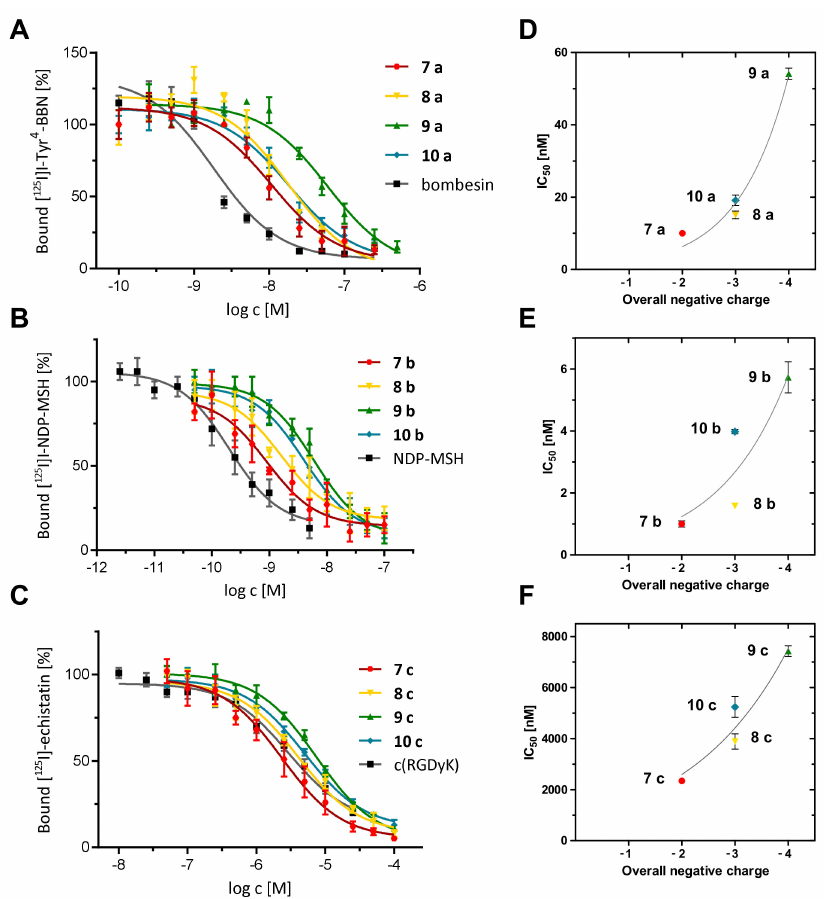
Figure 6. Results of the competitive displacement assays of the peptide-MIU-bioconjugates on different tumor cell lines. Depiction of the determined binding curves of: ( A ) 7 a - 10 a and the reference bombesin, tested on stably GRPR-transfected HEK-293 cells, using [ 125 I]I-Tyr 4 -bombesin as the competitor, ( B ) 7 b - 10 b and the reference NDP-MSH, tested on MC1R-positive B16F10 cells, using [ 125 I]I-NDP-MSH as the competitor, ( C ) 7 c - 10 c and the reference c(RGDyK), tested on α v β 3 - expressing U87MG cells, using [ 125 I]I-echistatin as the competitor. Correlation between the found IC 50 values and number of negative charges of: ( D ) 7 a - 10 a , ( E ) 7 b - 10 b and ( F ) 7 c - 10 c . Error bars represent